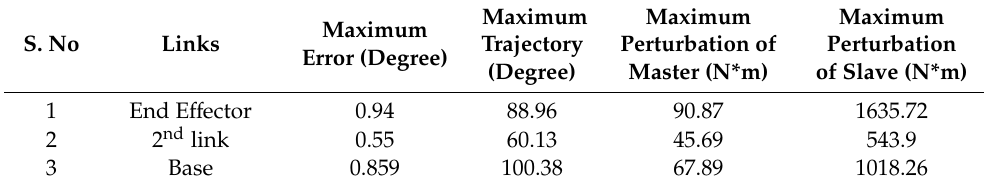
Table 4. Maximum trajectories, error and perturbation between master and